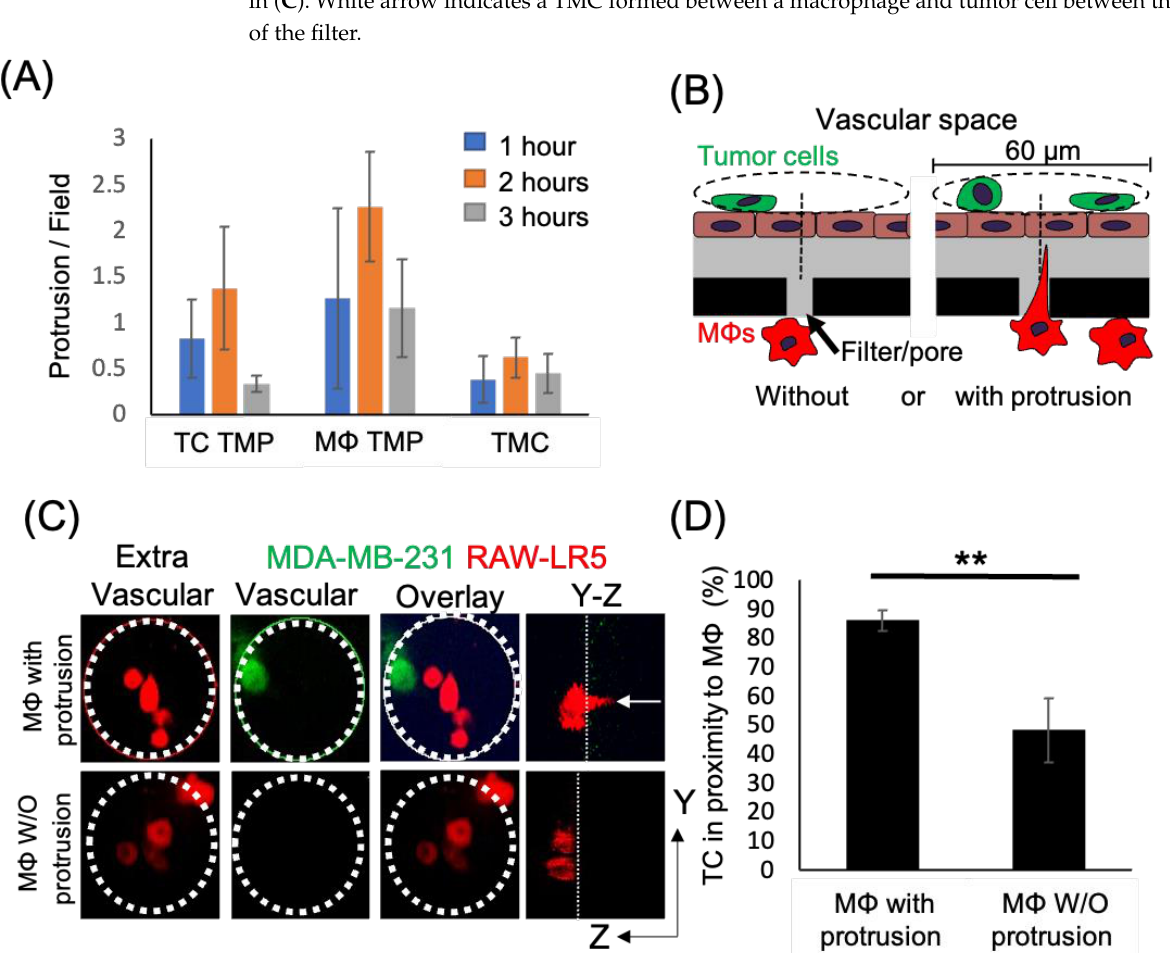
Figure 2. Tumor cell localization to macrophages occurs in high frequency when macrophages contain thin membranous protrusions towards the upper surface. ( A ) Time course of the formation of thin membranous protrusions (TMP) and thin membranous connections (TMC) over time in the eTEM assay. N = 3 experiments. ( B ) Schematic of quantification strategy for the proximity assay with green tumor cells located on top of the endothelial layer (brown) in the vascular space and macrophages (red) in the extravascular space. A 60 µm diameter circle (dashed line) is centered around a pore containing macrophages, either with (right) or without (left) protrusions. The presence of tumor cells on the vascular surface within the circle (dashed line) was scored. ( C ) Representative images of the macrophages (red) in the extravascular space and tumor cells (green) in the vascular space in the eTEM assay 2 hours after tumor cell introduction, along with an overlay of the two images to determine the co-localization of both cell types. Dotted white circle represents the analyzed area. White arrow in Y-Z orthogonal view marks the macrophage protrusion crossing the filter. ( D ) % of the time that tumor cells are found in proximity (within 30 µm radius) to macrophages with and without protrusions. N = 3 experiments, ** p value < 0.01.